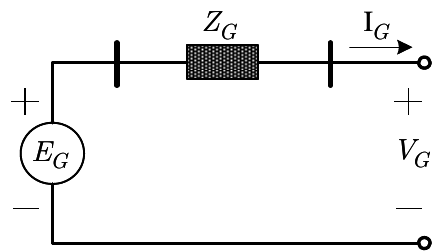
Figure 3. Generator equivalent circuit model (GECM).